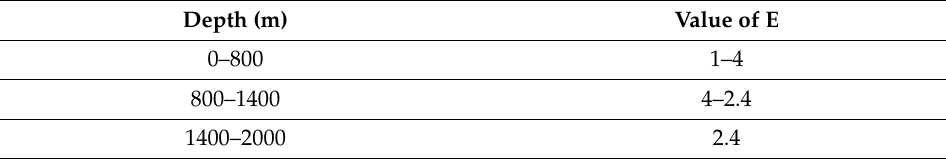
Table 2. Value of E at various depths.